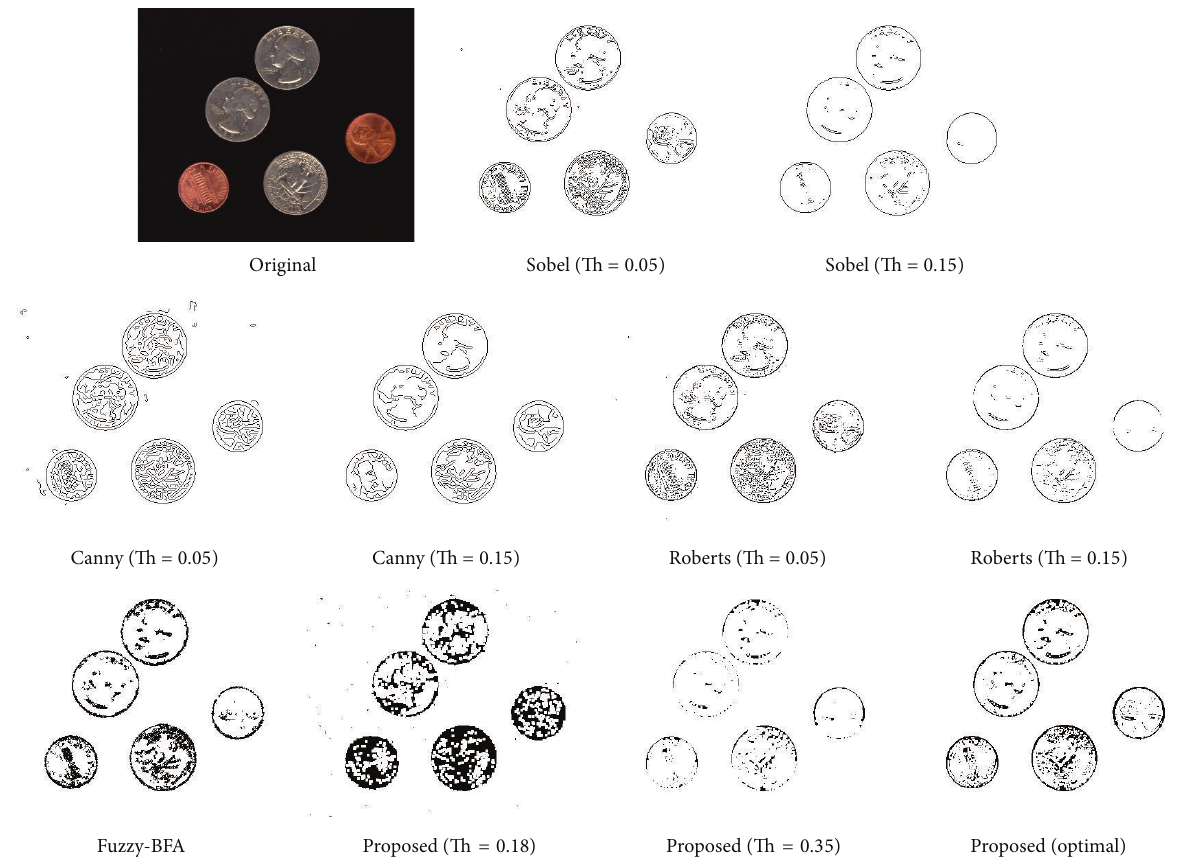
Figure 14: Edge detection results of “coins” image: Sobel, Canny’s, and Roberts methods using thresholds = 0.05 and 0.15; fuzzy-BFA method; proposed method with fixed thresholds (0.18 and 0.35) and optimal threshold.